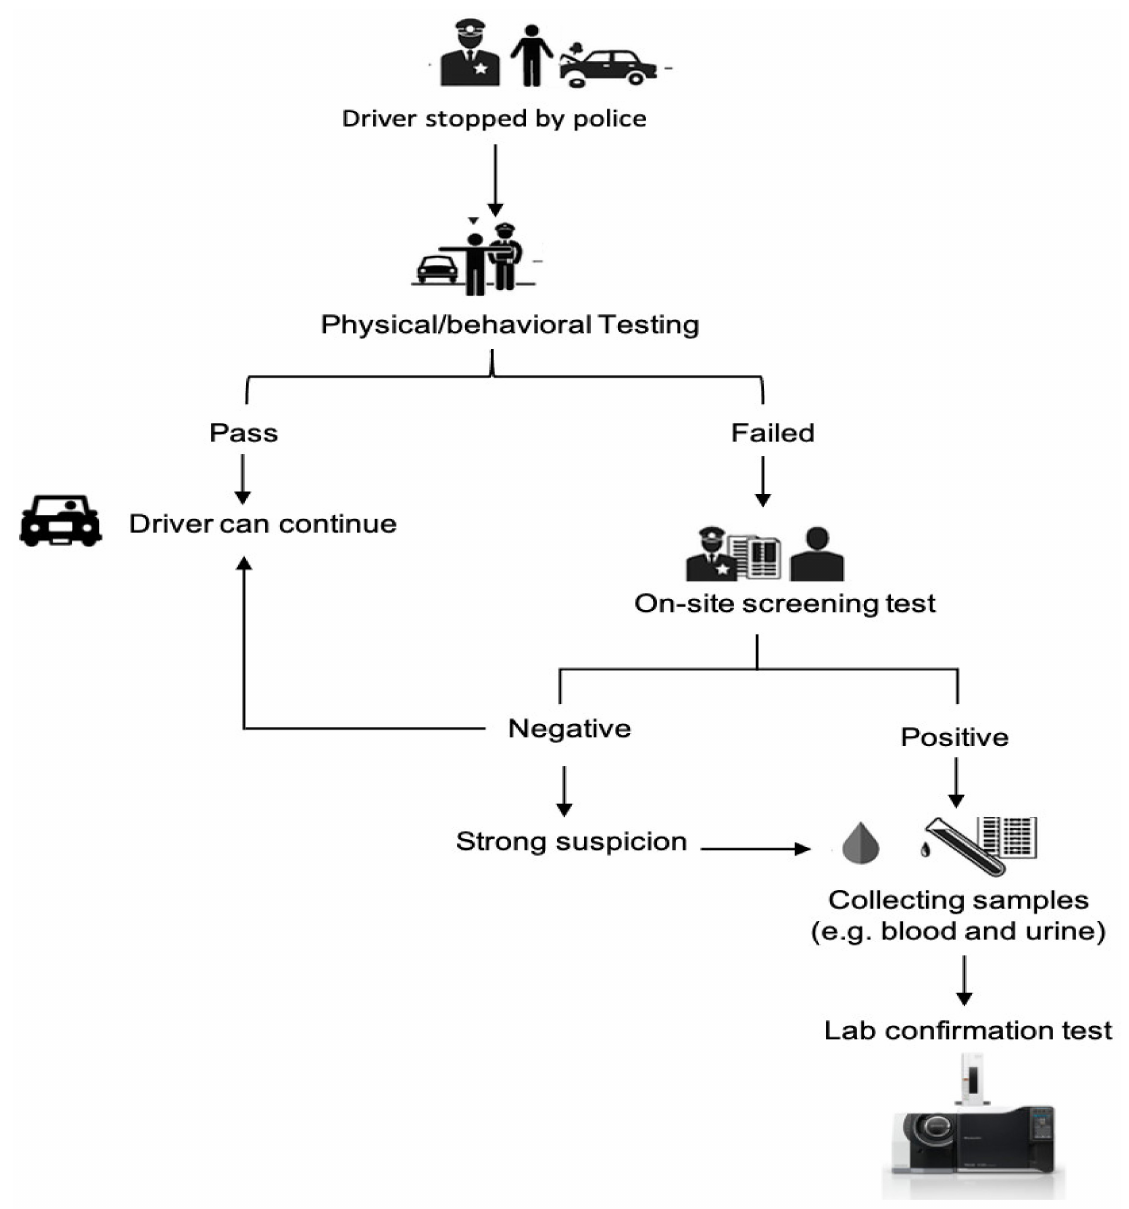
Figure 1. Flow diagram of legal procedures in the